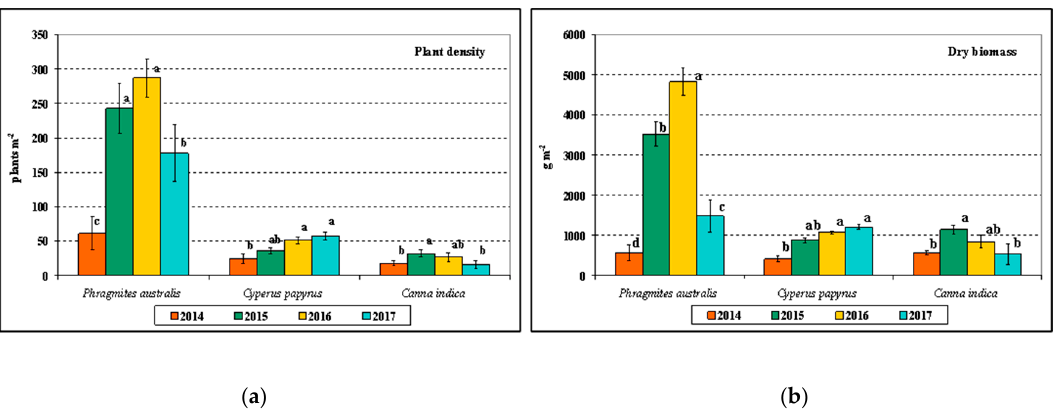
Figure 8. Average plant density ( a ) and dry biomass production ( b ) ( ± SD) of CW plant species for each year of trial. Different letters indicate significant statistical differences for p < 0.05 for the same plant species.